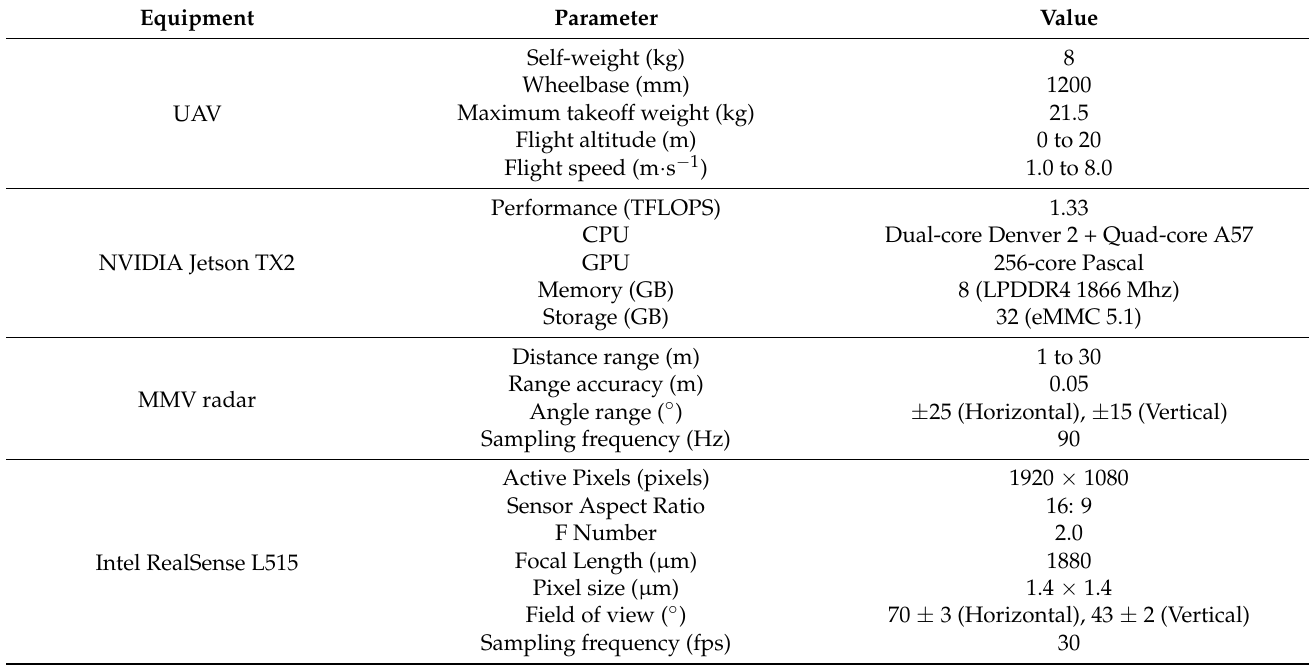
Table 1. Parameter of the experimental